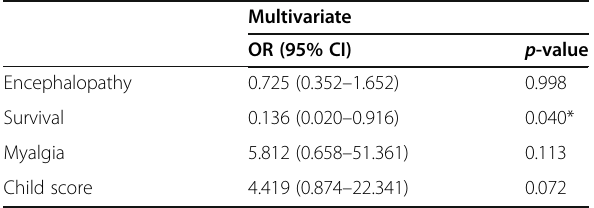
Table 4 Multivariate analysis of the effect of simvastatin in improving the survival